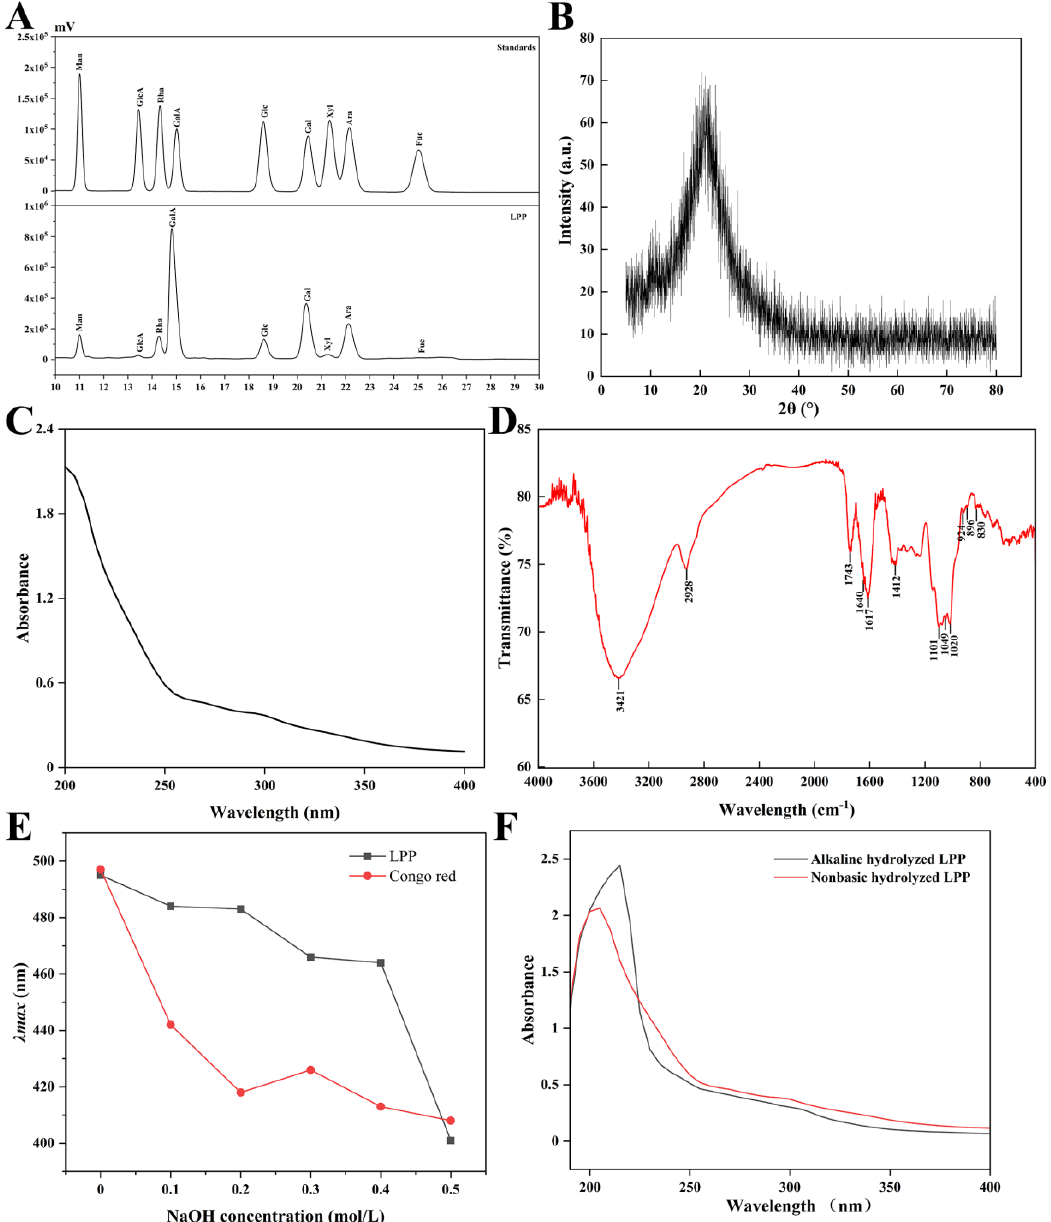
Figure 1. ( A ) Monosaccharide composition, ( B ) XRD, ( C ) UV-vis spectrum, ( D ) FT-IR spectroscopy, ( E ) Congo red experiment, and ( F ) β -elimination reaction for the Lonicera caerulea L. pomace polysac- charide